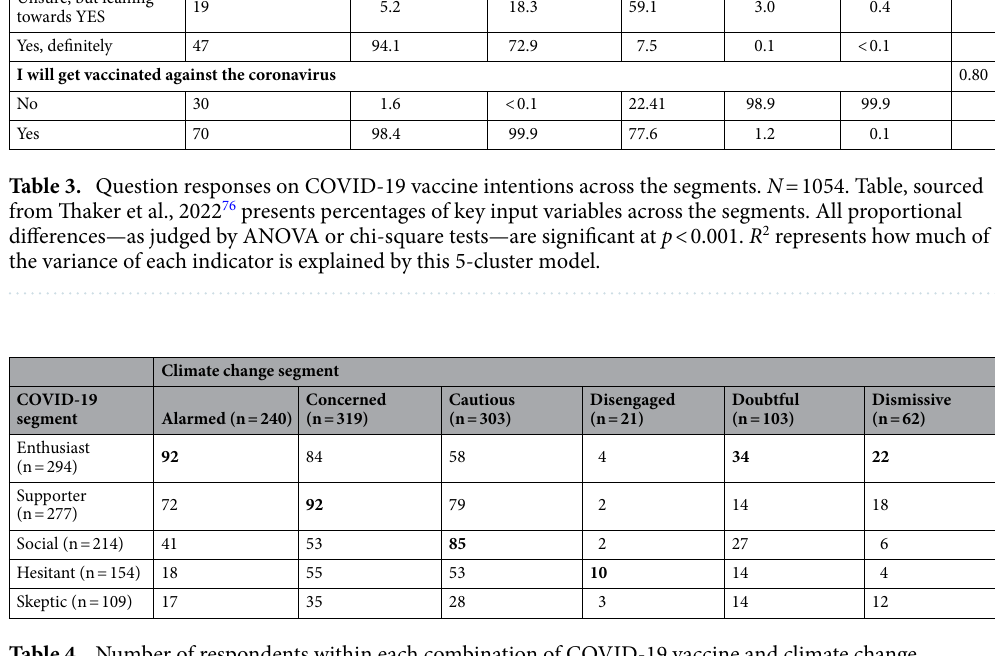
Table 4. Number of respondents within each combination of COVID-19 vaccine and climate change segments. Bold values contain the largest vaccine segment proportion within each climate change